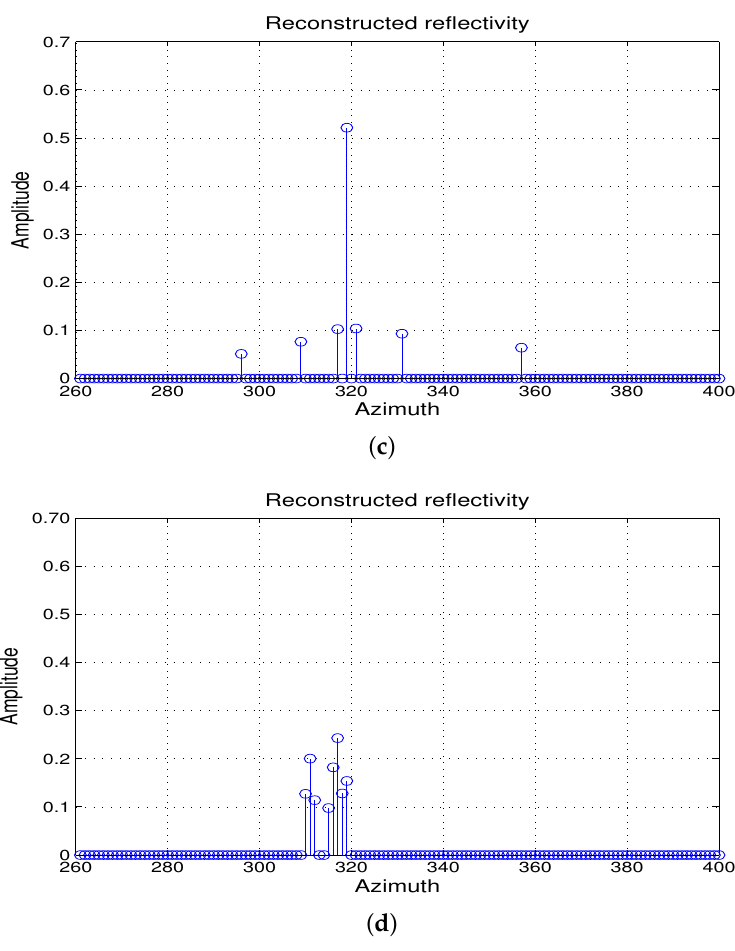
Figure 3. ( a ) SAR image in 2D containing moving object, highlighted by the rectangle; ( b ) plot of the normalized amplitude from range bin No. 179 in the 2D image; the rectangle contains defocusing caused by the moving target; ( c ) reconstructed reflectivity using DGAOMP: localization and low sidelobes can be seen; ( d ) reconstructed reflectivity ignoring acceleration rate: spreading and higher sidelobes compared to the results with DGAOMP can be